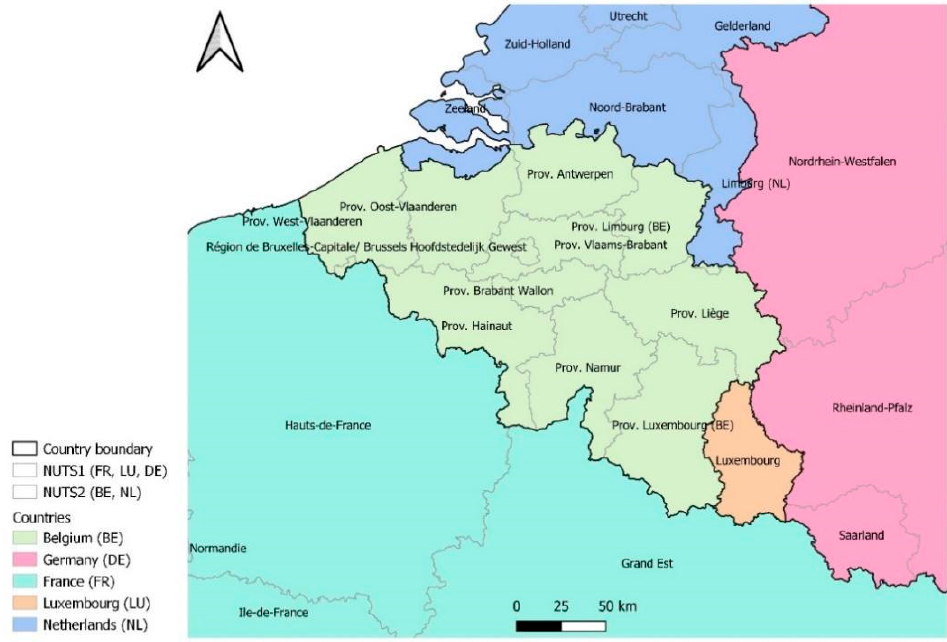
Figure 1. The subnational (NUTS) areas considered for analysis in Belgium and its neighboring